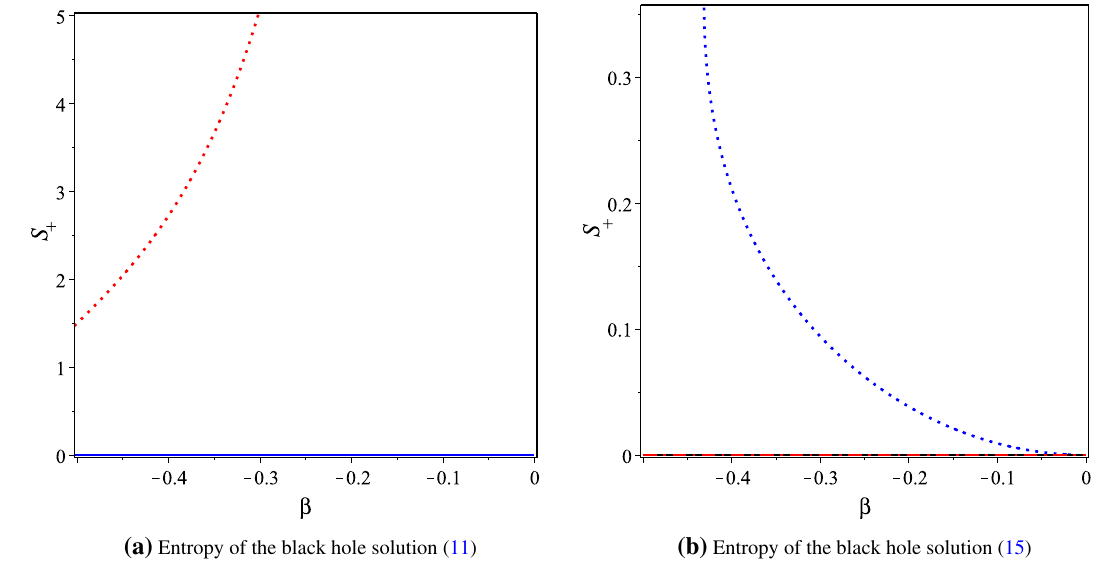
Fig. 3 Schematic plot of the radial coordinate r versus the dimensional parameter β that characterizes the spherically symmetric black holes (11) and (15)